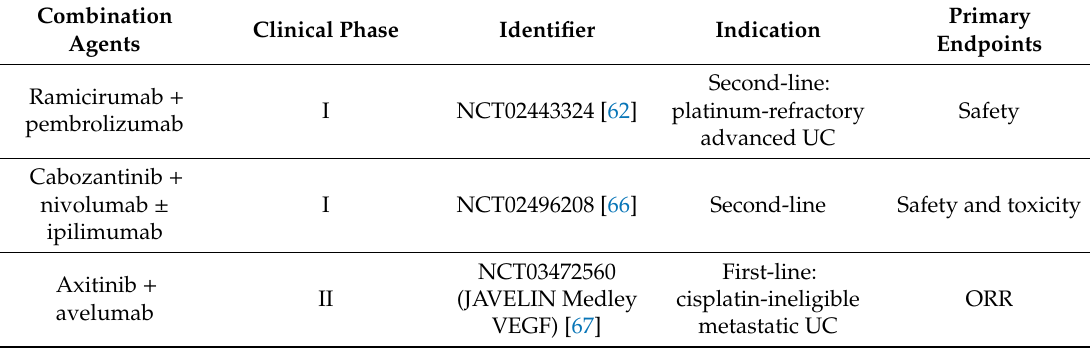
Table 5. Ongoing trials evaluating anti-angiogenic therapies for urothelial